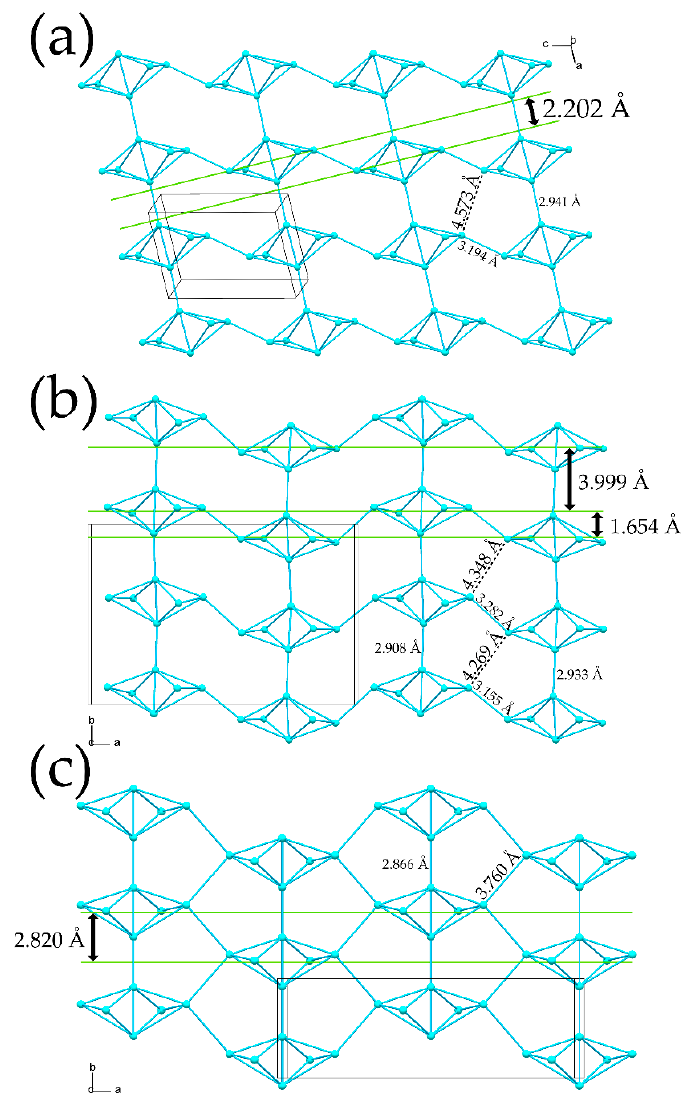
Figure 3. Cu-based layers in the crystal structures of 1 ( a ), 2 ( b ) and Rb 2 Ca[Cu 3 O] 2 (PO 4 ) 4 ( c ). Thin black lines show boundaries of unit cells. Legend: as in Figure 1. See details in the text. Table 2. Selected crystallographic and structural complexity parameters for shchurovskyite-type structures.